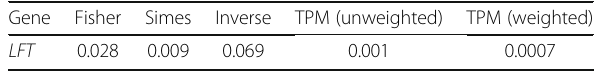
Table 4 Gene-based analysis of association of genetic variants in LTF with the risk of dental caries Gene Fisher Simes Inverse TPM (unweighted) TPM